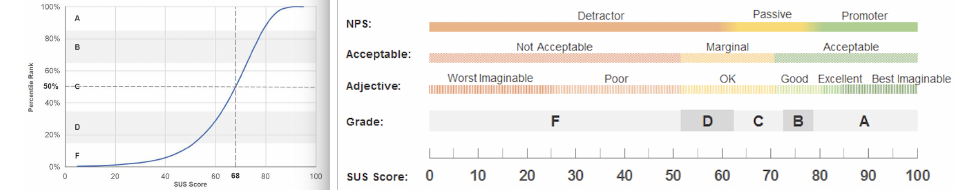
Figure 4. SUS on a curve with percentile ranks and grades (Usability.gov, accessed on 1 January